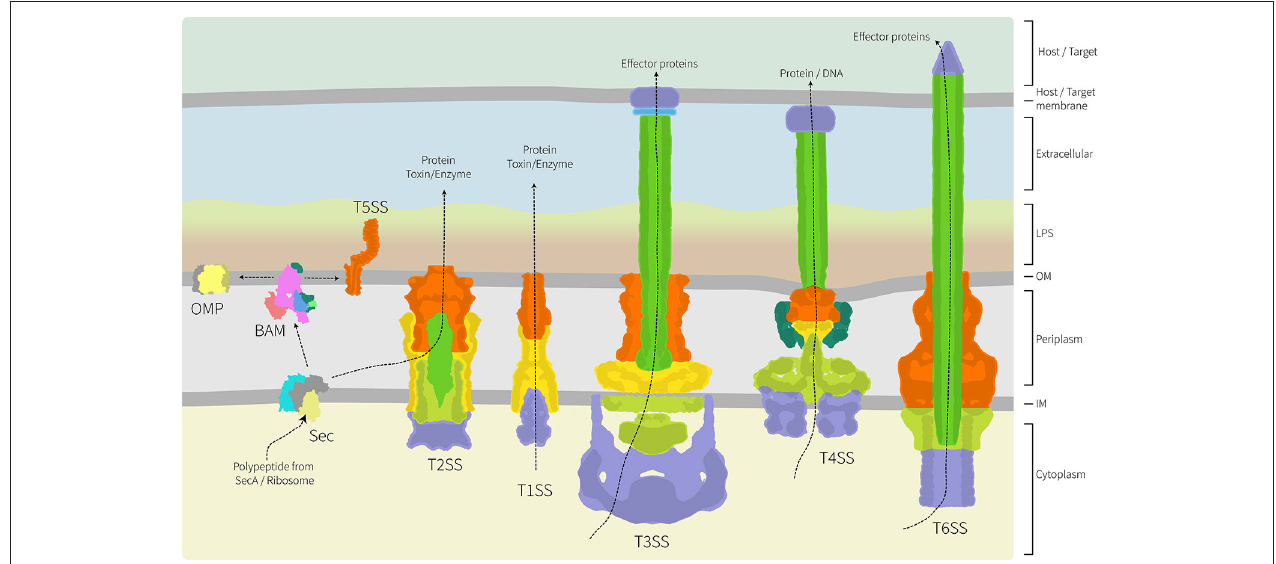
FIGURE 2 | Architecture of the major protein secretion systems found in Gram-negative bacteria. Of the six major protein secretion systems, five span the inner and outer membranes and the periplasm. These nanomachines are thereby trapped in the peptidoglycan layer. The T1SS, T3SS, T4SS, and T6SS collect substrate proteins directly from the cytoplasm for secretion across both membranes, while the T2SS collects substrate proteins from the periplasm with their delivery there being via the Sec translocon (shown) or Tat transport system (not shown). While informed artistic license was taken with the placement, orientation and shape of some proteins/complexes, wherever possible relative structural information was used. The structural data used as a basis in the preparation of this figure are: PDB 1ek9, 5l22, 5mg3, 5d0o, 1mal, 5ksr, 5wq8, 3fpp, 4ksr, 5l22, 3fpp, 4kh3, 4mee; and EMD-2927, EMD-2667, EMD-2567, EMD-1875. The structure and function of these various protein translocation systems are detailed elsewhere in this special